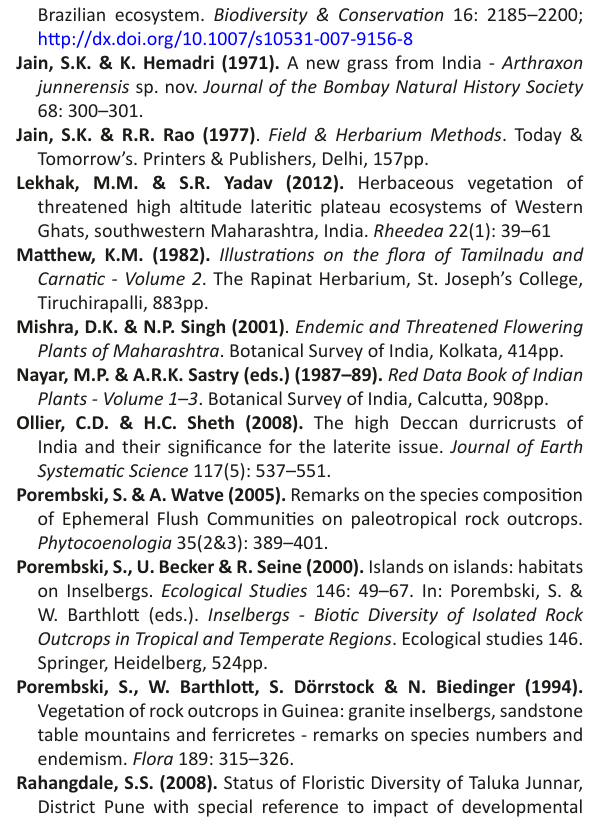
table mountains and ferricretes - remarks on species numbers and endemism. Flora 189: